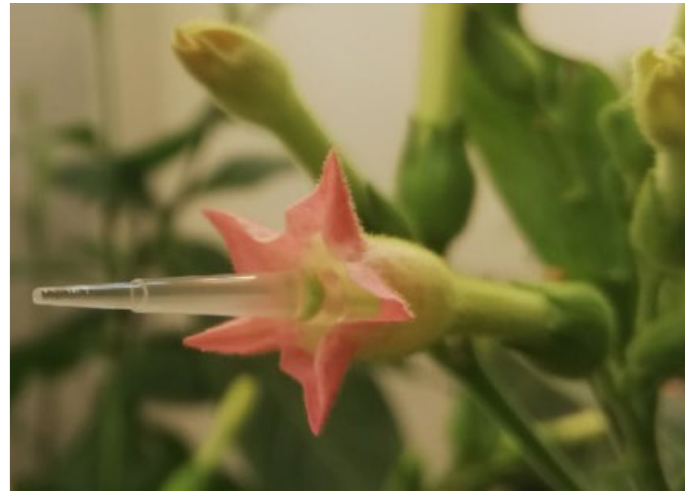
Figure 4. Emasculated tobacco flower at stage 2 with a tip that collects exudate.